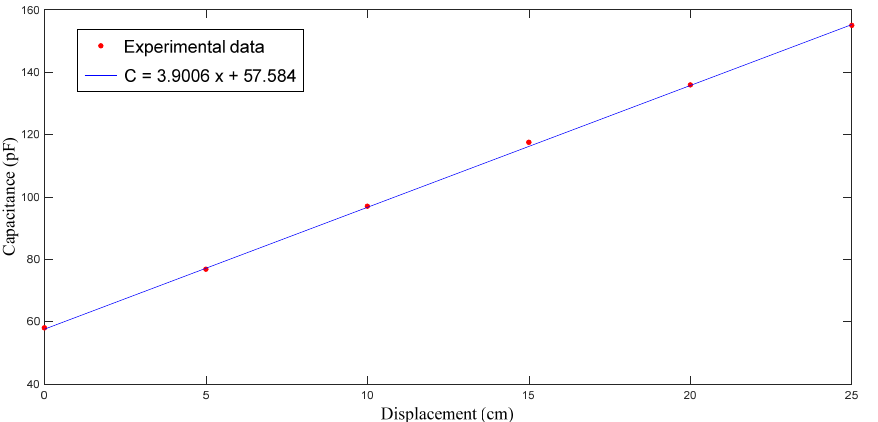
Figure 12. Capacitance measured during the second RTM experiment using a nine-layer fiber pre- form.